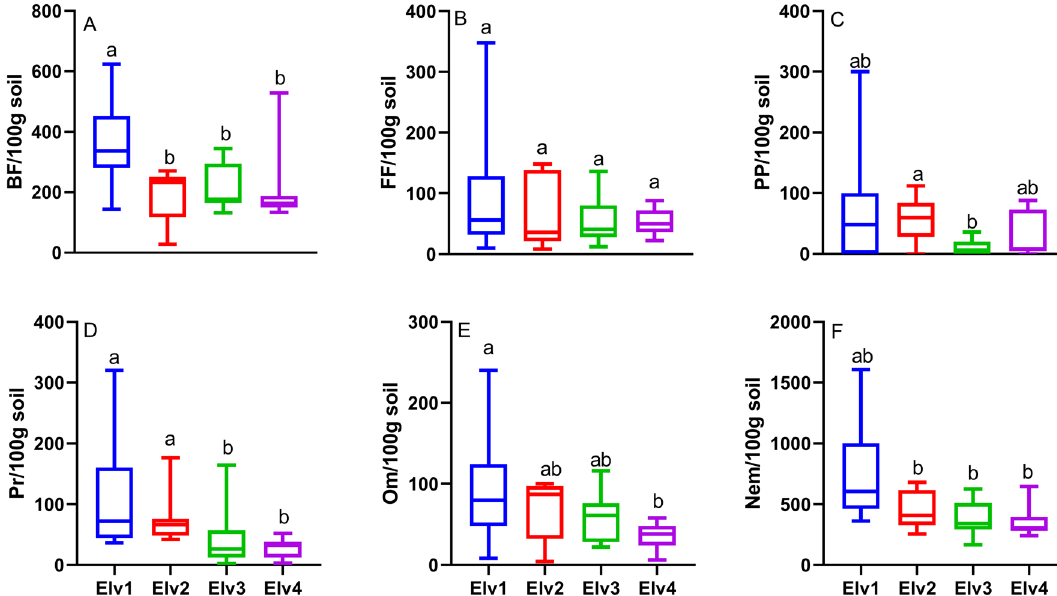
Figure 3. Nematode Abundance of various feeding (trophic) groups across elevation. ( A ) BF (Bacterial Feeders); ( B ) FF (Fungal Feeders); ( C ) He (Herbivores); ( D ) Om (Omnivores); ( E ) Pr (Predators); ( F ) Nem (Total Nematode Abundance). Different small case letters across a panel denote significant differences.